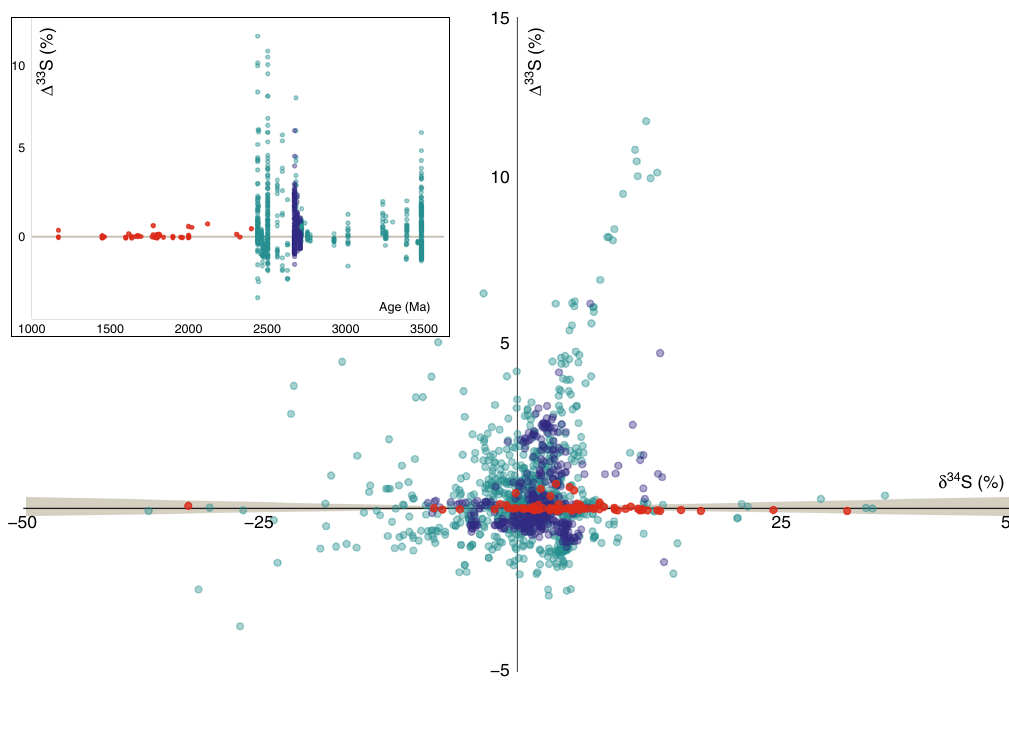
Fig. 2 Multiple sulfur isotope results. Results from the Capricorn Orogen (bright red; n = 78) overlain on a compilation of published multiple sulfur isotope data from the Pilbara (green; n = 840) and Yilgarn (blue; n = 381) cratons. Beige area represents limit of MDF-S 34 . Data are cited in the Supplementary Information. Error bars are in every instance smaller than the symbol. Inset of same data plotted as Δ 33 S versus age with beige line representing the extent of